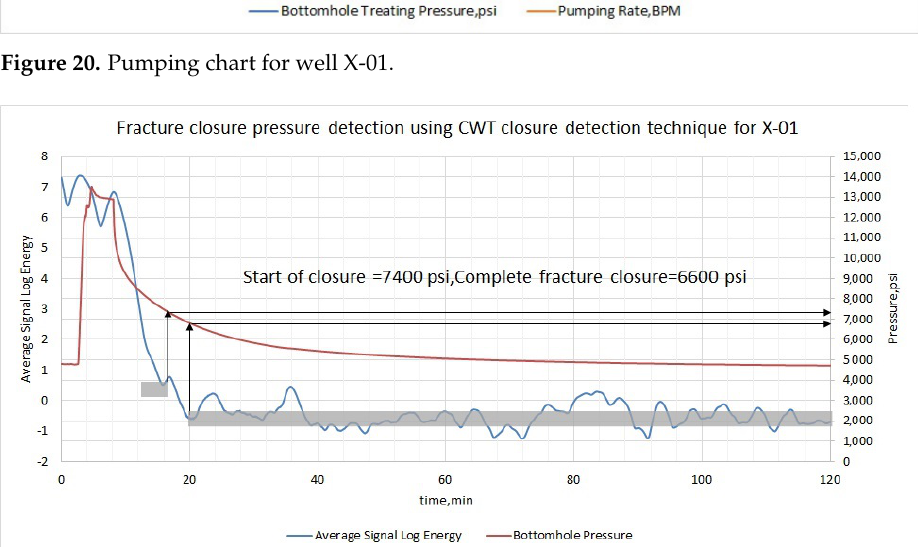
Figure 21. Closure pressure detection using CWT closure detection technique for well